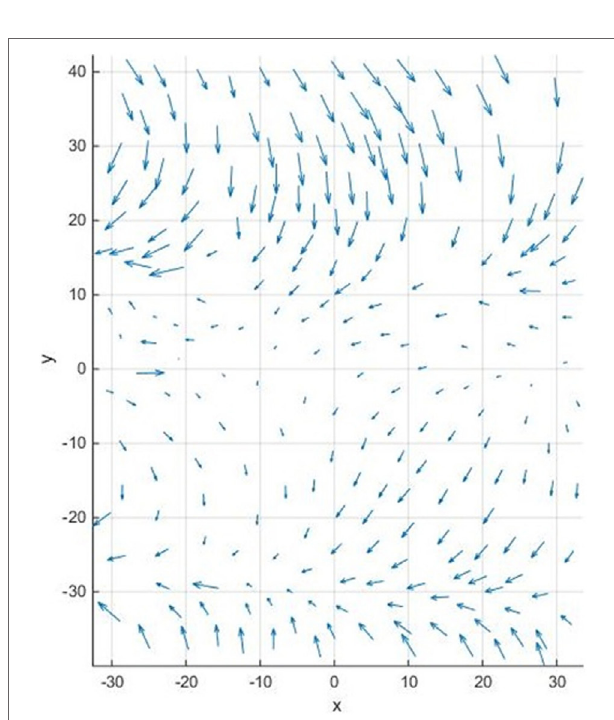
FIgURe 12 | An example of horizontal u and v components of full 3D surface velocity vectors obtained for each thermal